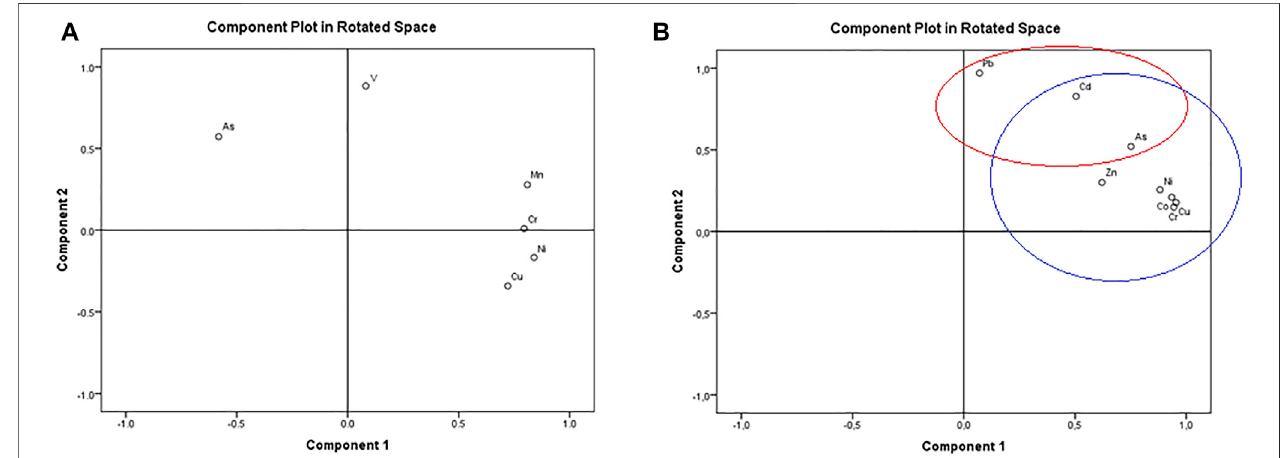
FIGURE 3 | PCA (R mode) for trace elements in water (A) and sediment (B) .